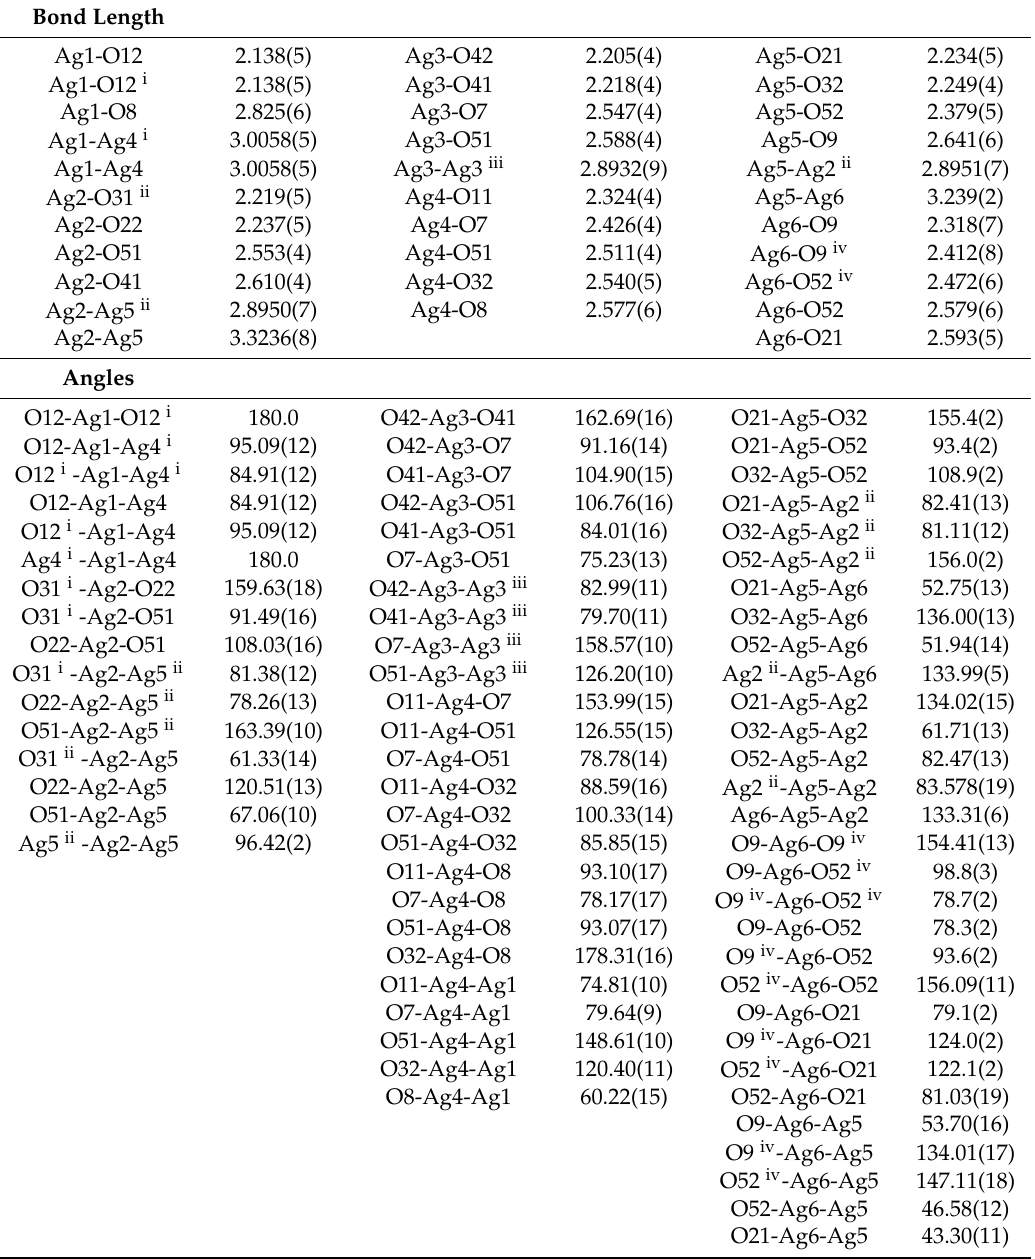
Table 1. Selected bonds lengths [Å] and angles [ ◦ ] for [Ag 5 (O 2 CC 2 F 5 ) 5 (H 2 O) 3